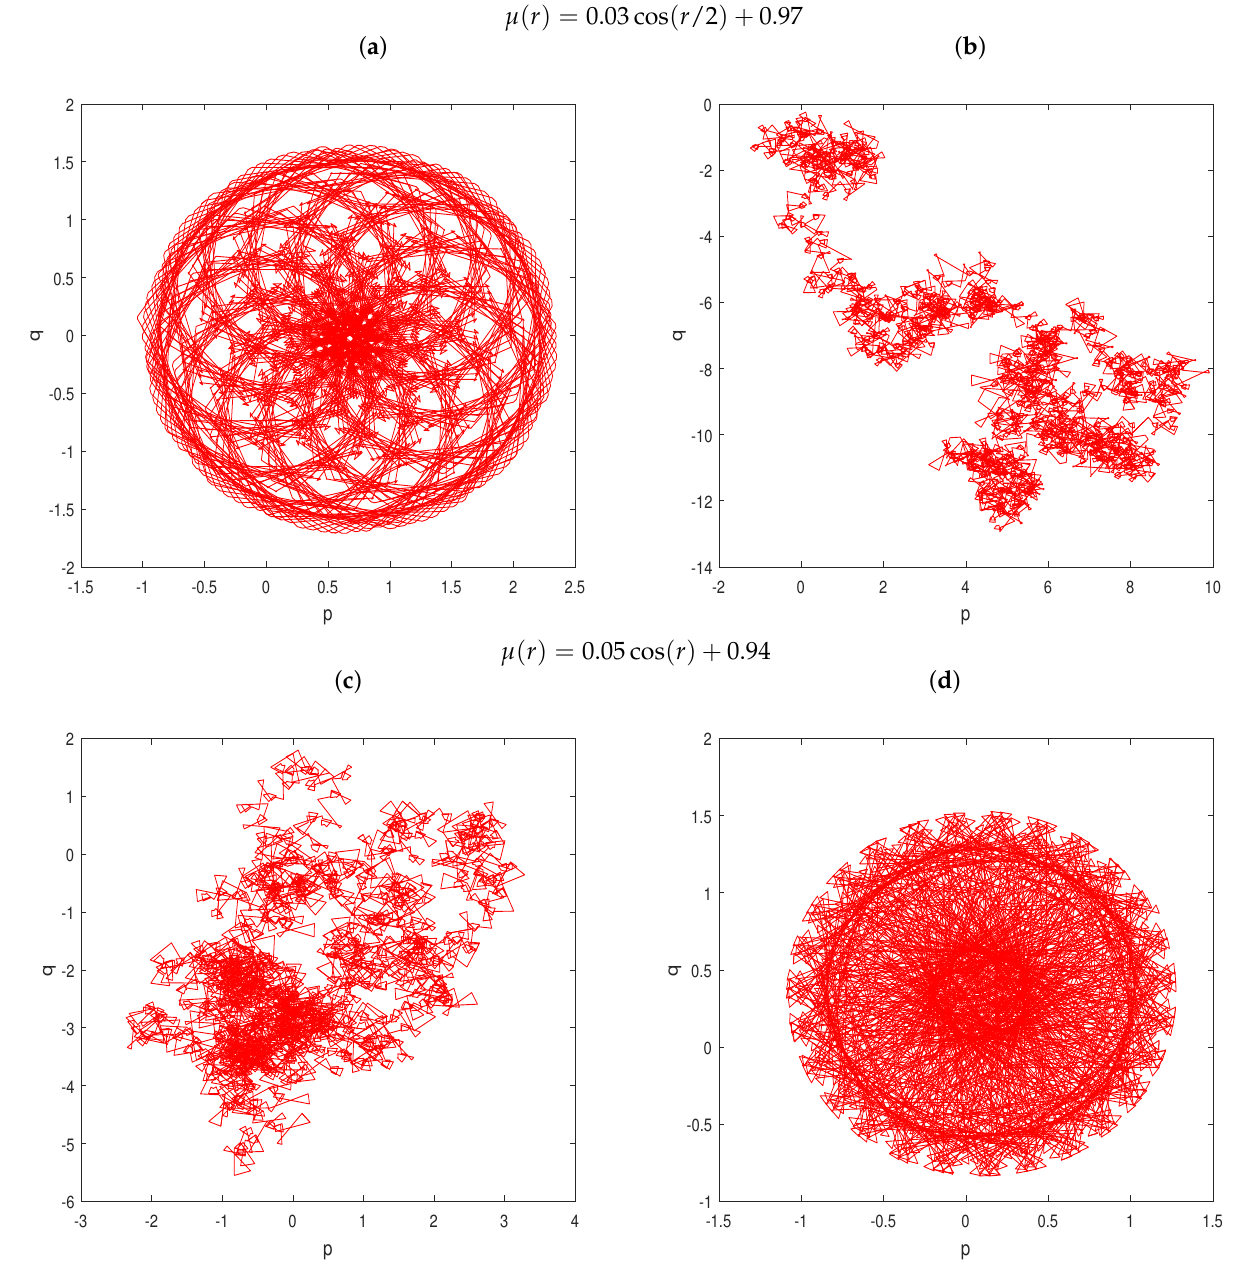
Figure 7. The p-q plots of the 0–1 test of the Tinkerbell map with the fractional variable-order (8) for distinct fractional variable-orders and values of β : ( a ) β = − 0.26, ( b ) β = − 0.34, ( c ) β = − 0.6013, ( d ) β = −